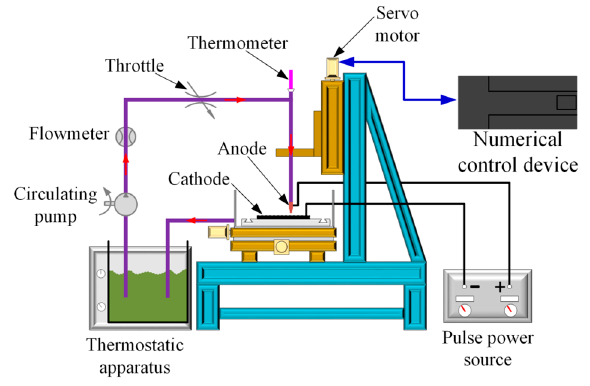
Figure 1. Schematic image of pulse jet electrodeposition.